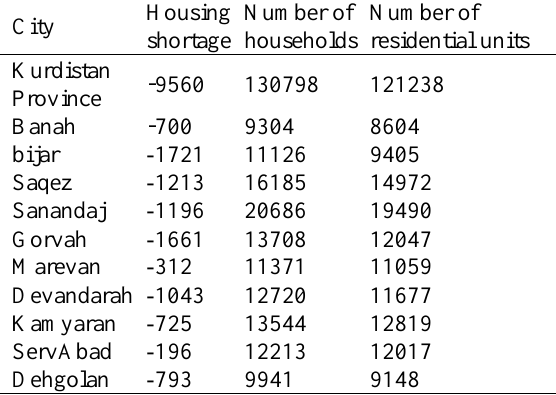
Table 5. Estimates of rural housing shortage in